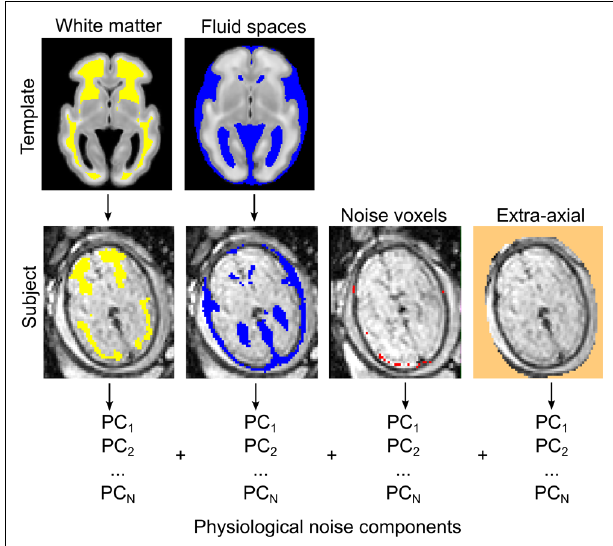
FIGURE 5 | Estimating physiological noise components for the correction of fetal fMRI signal using an adaptation of the CompCor approach.Top row: white matter and CSF components are segmented from the GW-specific anatomical templates. Segmentations are transformed to individual subjects (bottom row) while the voxels with highest temporal variation, and other, extra-axial structures, are calculated from the data.These voxels are used to perform the component-based filtering of the nuisance signal, according to the CompCor method described by Behzadi etal. (2007). PCs, principal